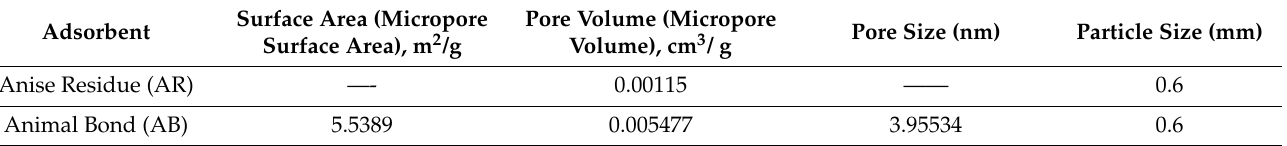
Table 8. Surface area, pore volume and pore size of both adsorbents.